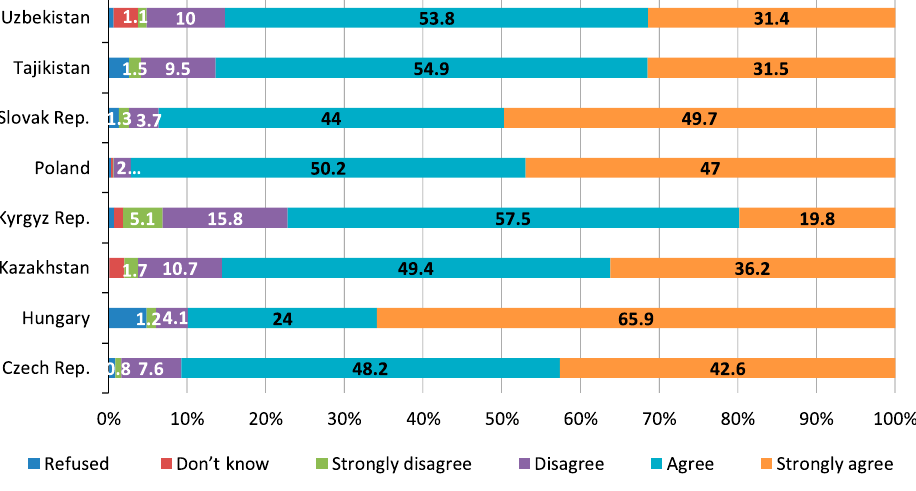
Source: own elaboration based on LiTS III, 2016, p.